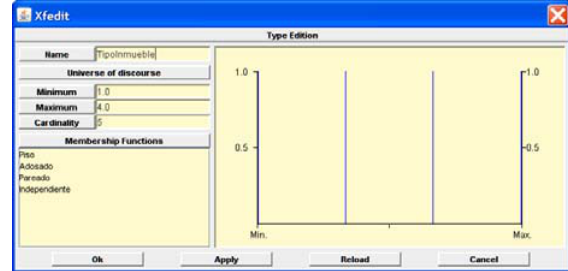
Fig. 2: Variable ‘type of